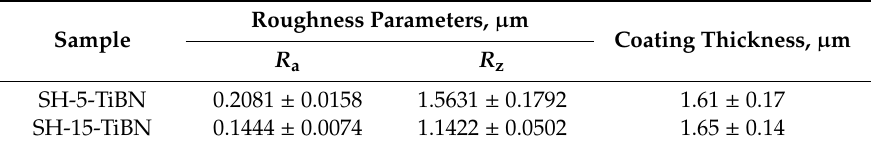
Figure 20. XRD pattern of coated sample: SH-5-TiBN and SH-15-TiBN.